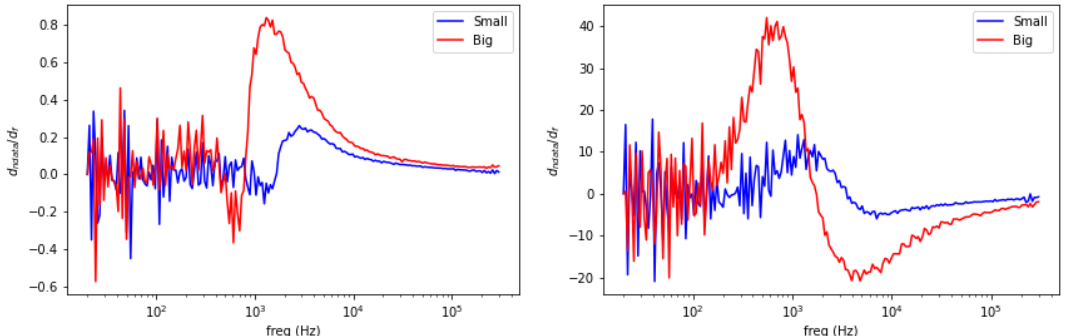
Figure 8. Spectral derivative for size variations ( left : amplitude, right : phase).